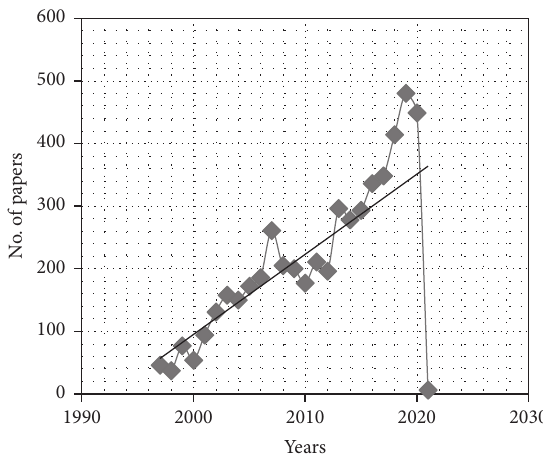
Figure 9: Content type and number of papers.